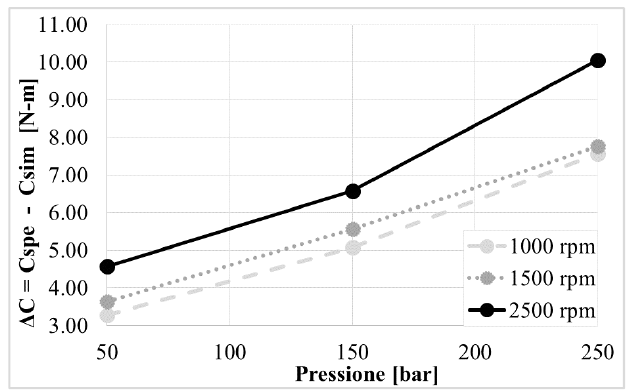
Figure 11. Absorbed torque—comparison between model and experimental data. ( a ) 1000 rpm, ( b ) 1500 rpm and ( c ) 2500 rpm.